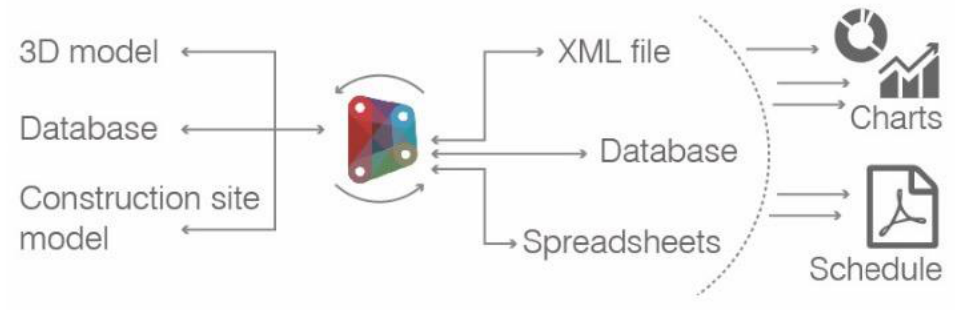
Figure 3. Dynamo dataflow.